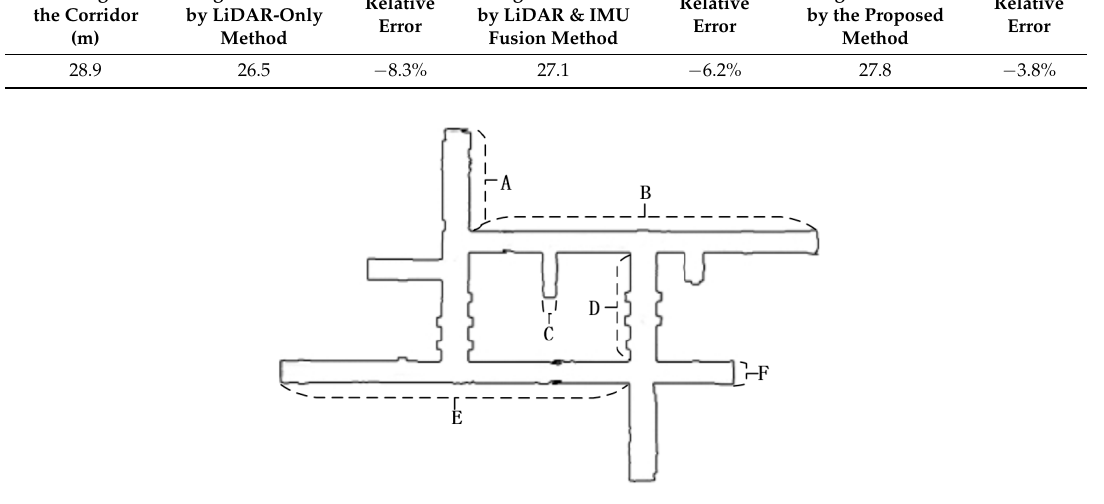
Figure 9. The selected segments in closed-loop scene.